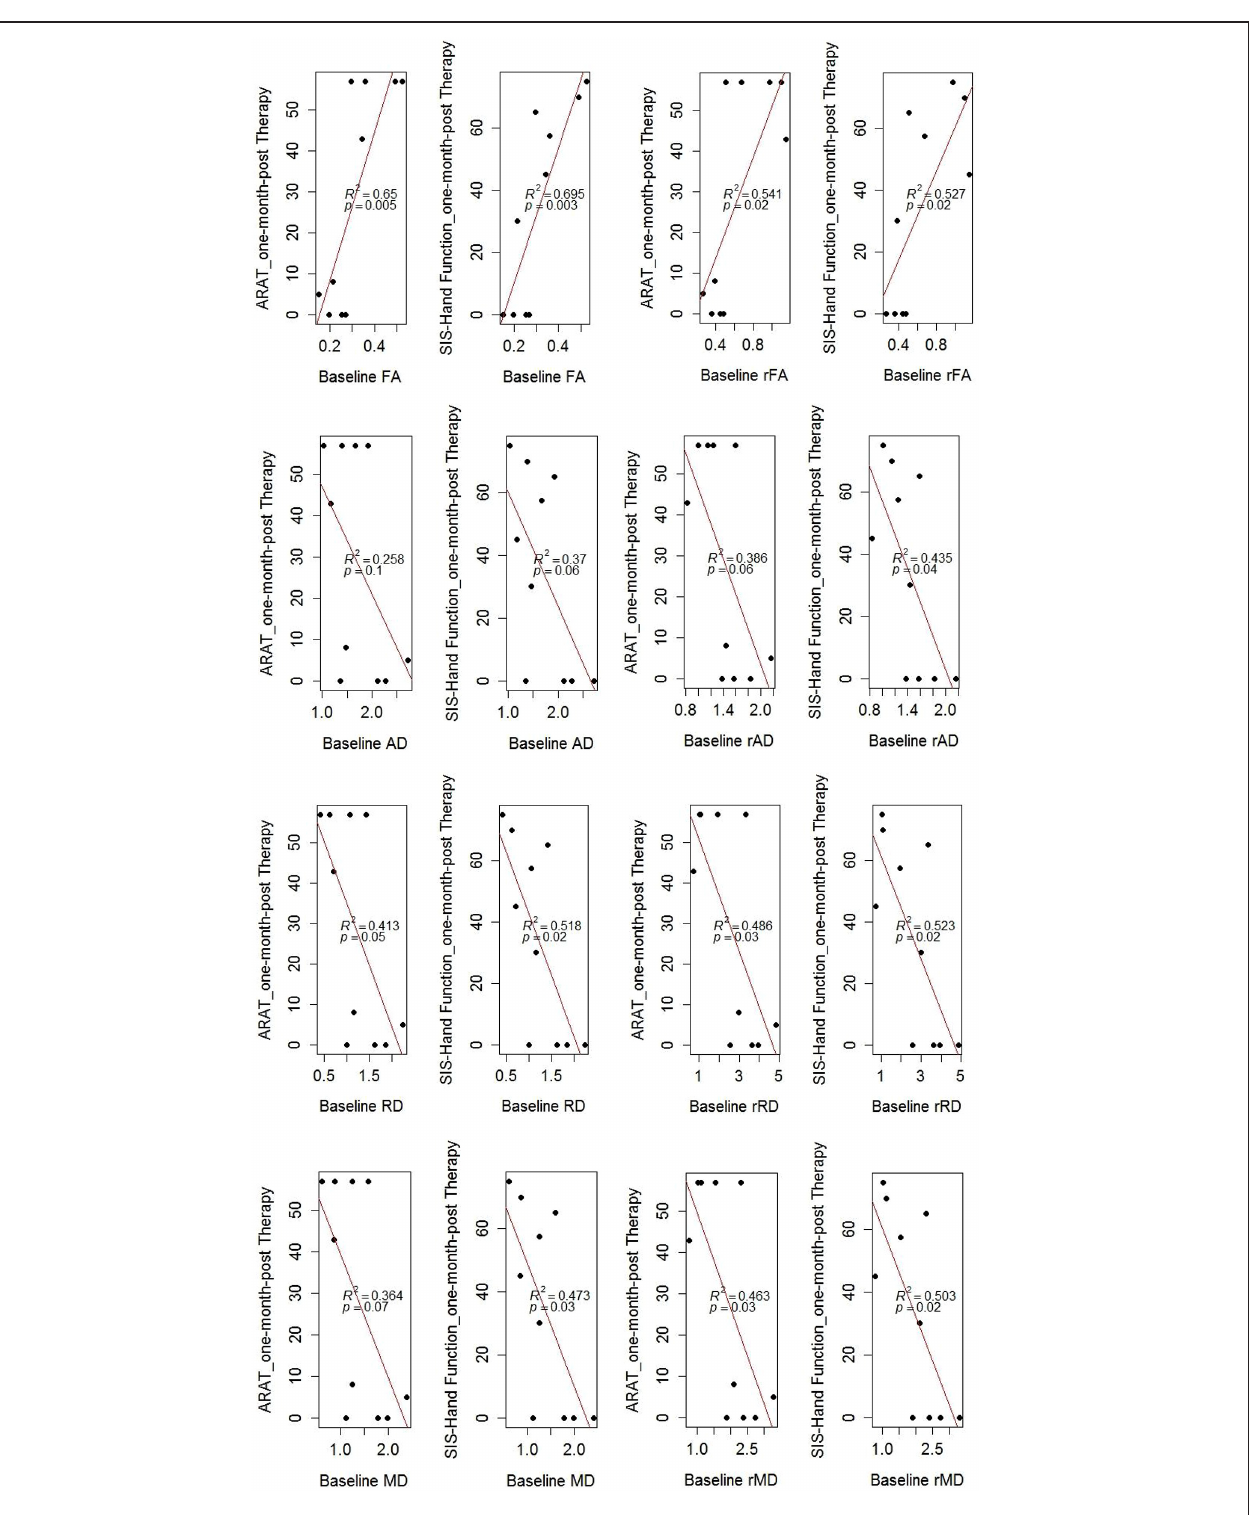
( R 2 ) and p -values of the regression model are shown on the figures. Note: there were three patients (CI002, CI009, and CT002) missing DTI scans at 1-month-post therapy, resulting 10 data points as seens in the figures.